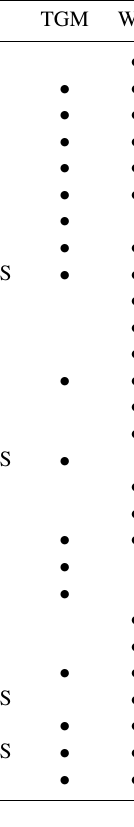
Table 3. Wet and dry annual deposition